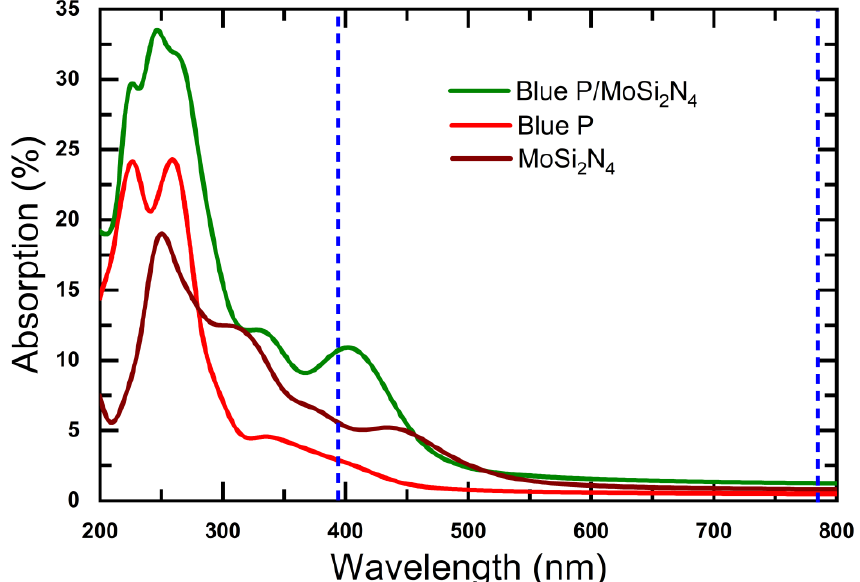
Figure 5. Optical absorption of the Blue P/MoSi 2 N 4 vdWH together with those of isolated Blue P and MoSi 2 N 4 MLs. The visible region is surrounded by blue dashed